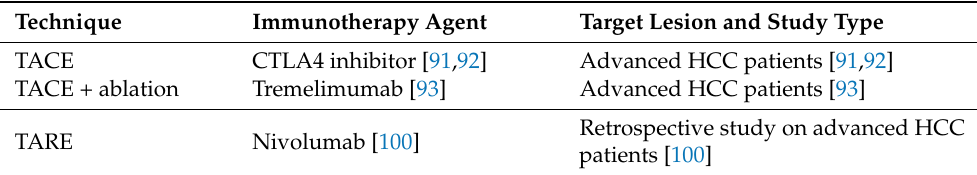
Table 4. Endovascular technique, immunotherapy agents, and target